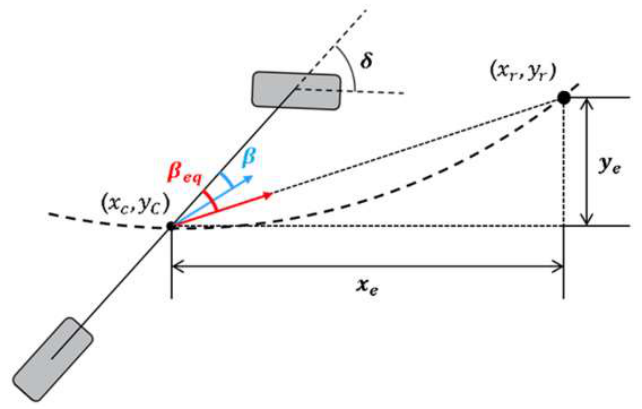
Figure 8. Vehicle state during drift driving.